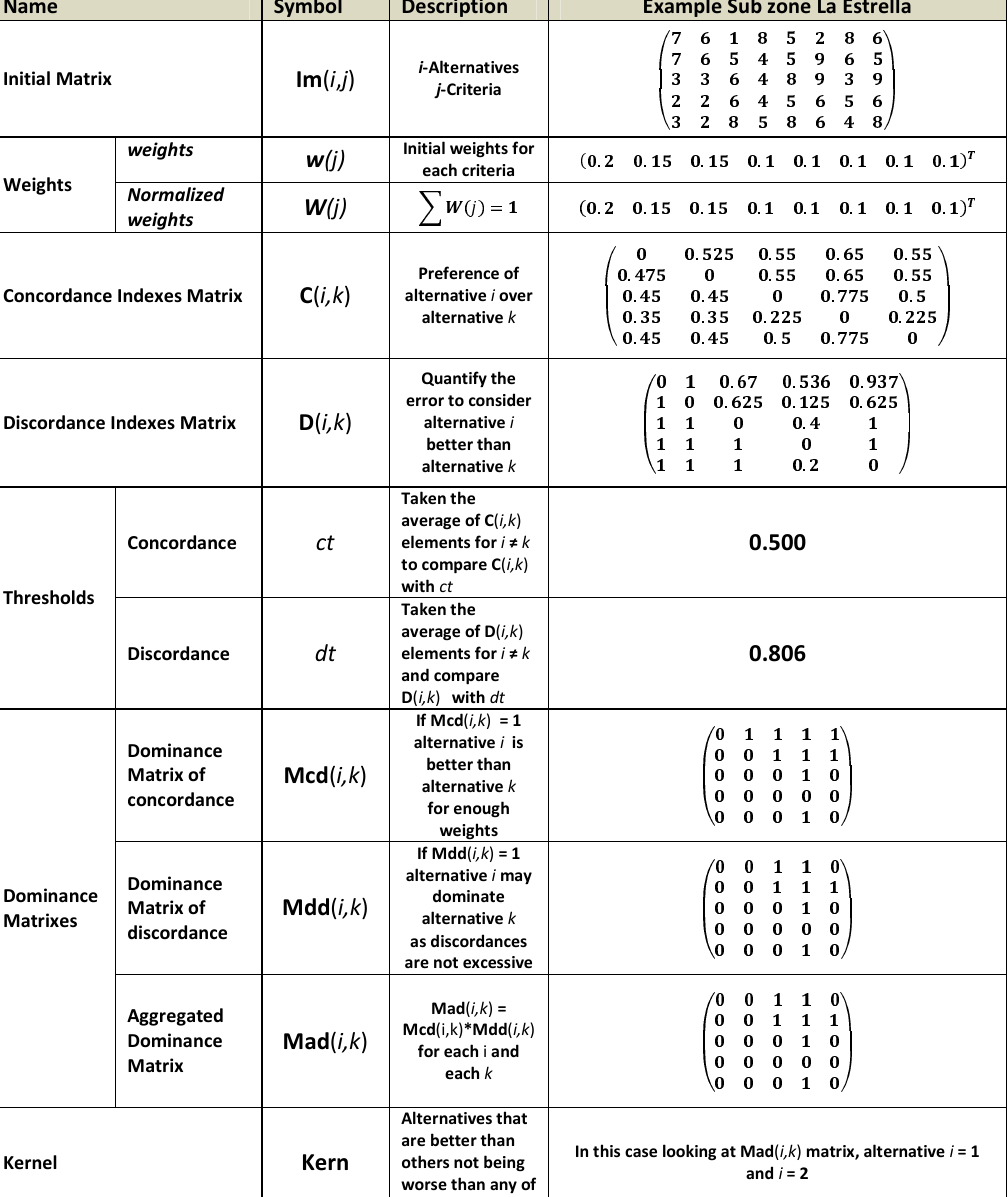
corresponding ELECTRE dominance graph, that indi- cates the alternatives (A) and (B) are in the kernel. That is for Concordance because they have higher values in Im matrix for criteria 1 (Water Erosion Index) and 2 (Eolian erosion index) that have higher weights (0.2 and 0.15), and no very bad values in that matrix for the other